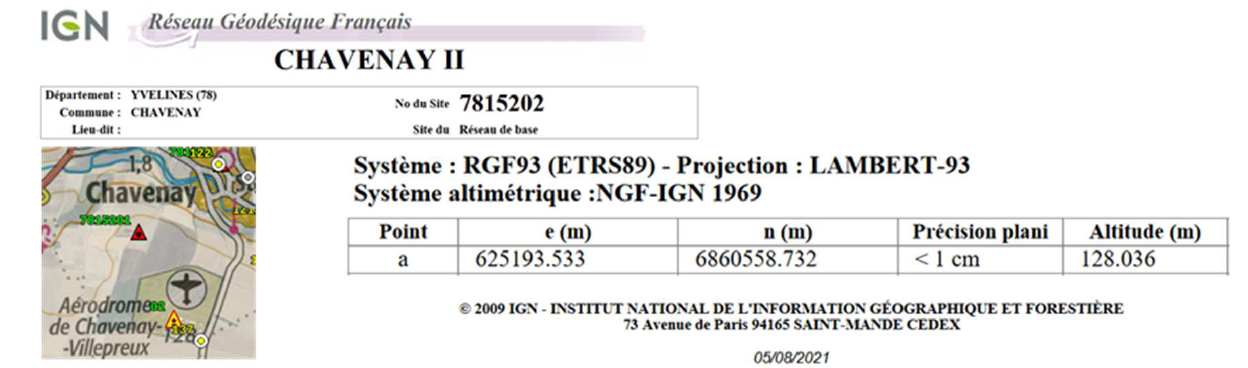
Figure 5. Chavenay II GNSS station (RGP network).